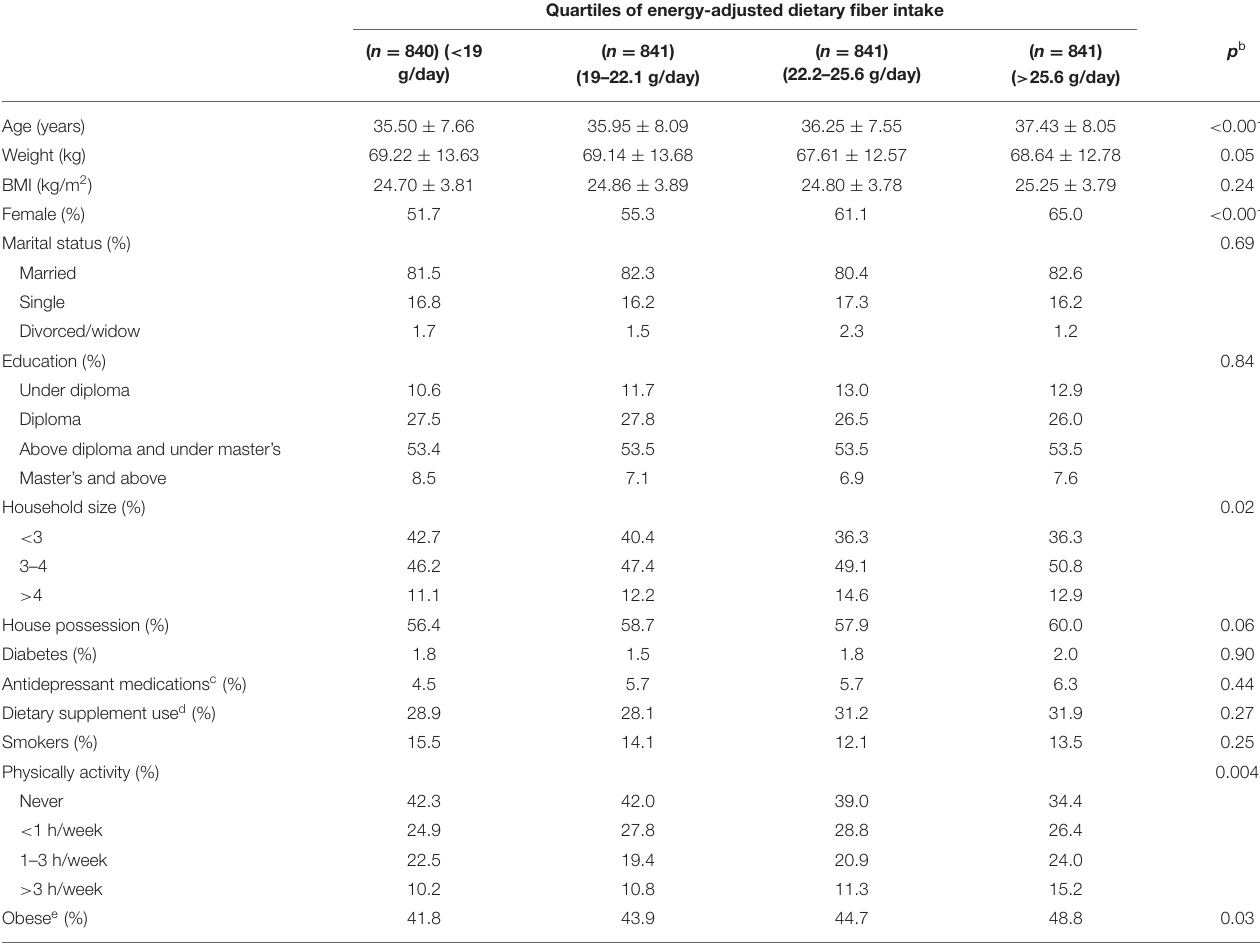
TABLE 1 | General characteristics of study participants across quartiles of energy-adjusted dietary fiber intake ( n = 3,362) a . Quartiles of energy-adjusted dietary fiber